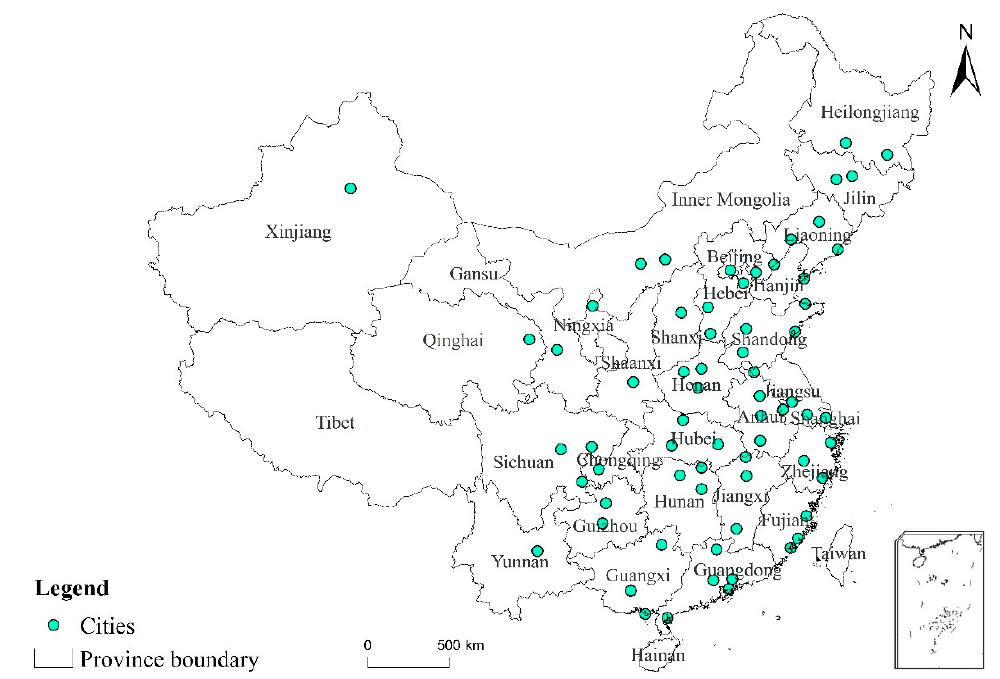
Figure 1. The location of the sample cities.